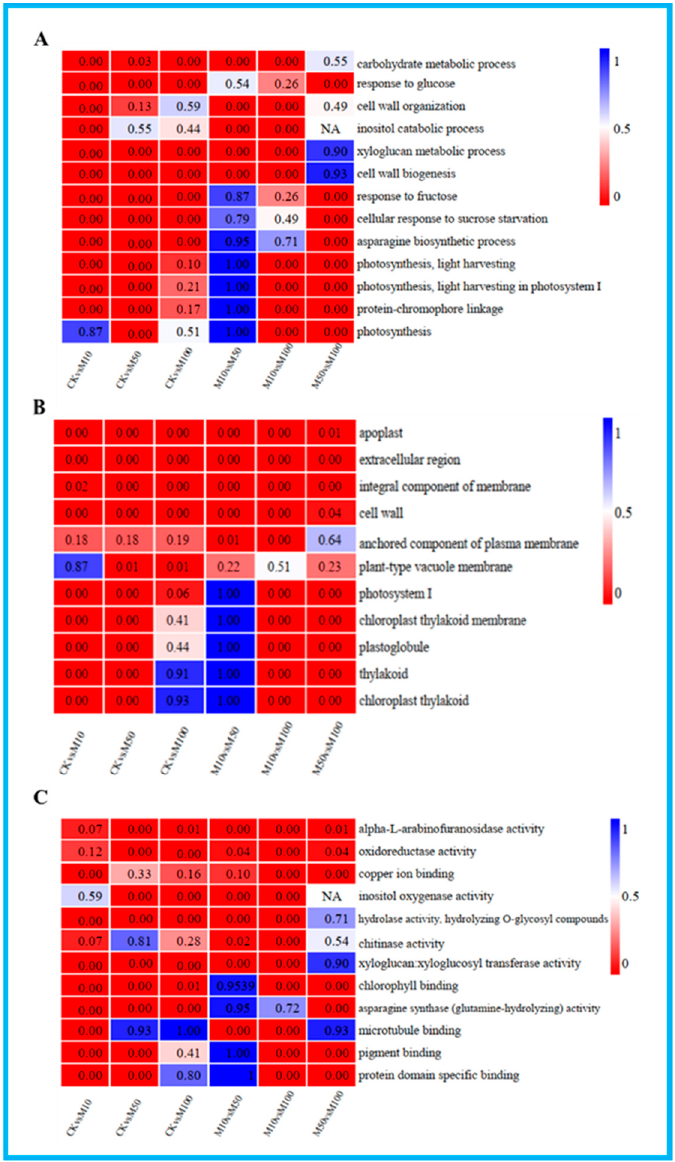
Figure 3. GO-terms enrichment analysis. From the red to blue corresponds to the numerical value of corrected Q and significant enriched GO-terms from the low to the high. ( A ), biological process; ( B ), cellular component; ( C ), molecular function.